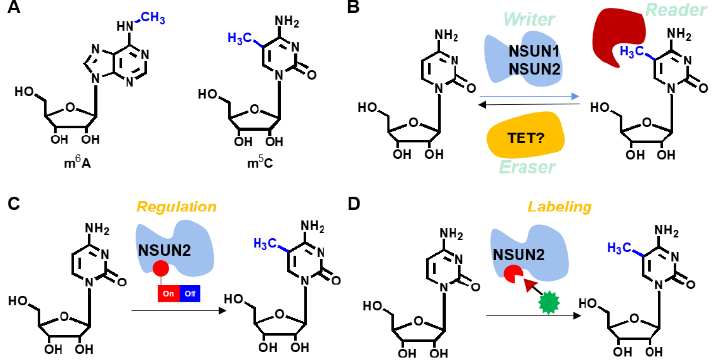
Figure 1. Investigations of RNA m 5 C modification. ( A ) Representative modifications in RNA, including m 6 A and m 5 C, among others. ( B ) m 5 C involved enzyme, including the ‘writer’ enzyme, NSUN2 . ( C ) Strategy of a switch precisely setting on the NSUN2 that regulates RNA methyl modification on cytosine 5 position by a gene encoding expansion technique. ( D ) Site-specific labeling of NSUN2 was achieved by gene encoding expansions and bio-orthogonal click reaction.